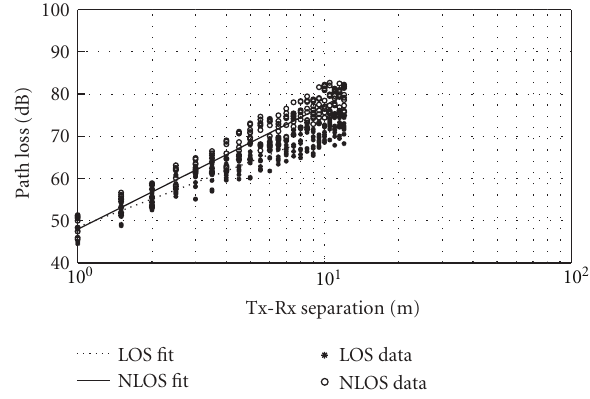
Figure 3: Scatter plots of path loss versus T-R separation in short- range o ffi ce environment at 5.8GHz. The straight line is least squares linear regression fit.